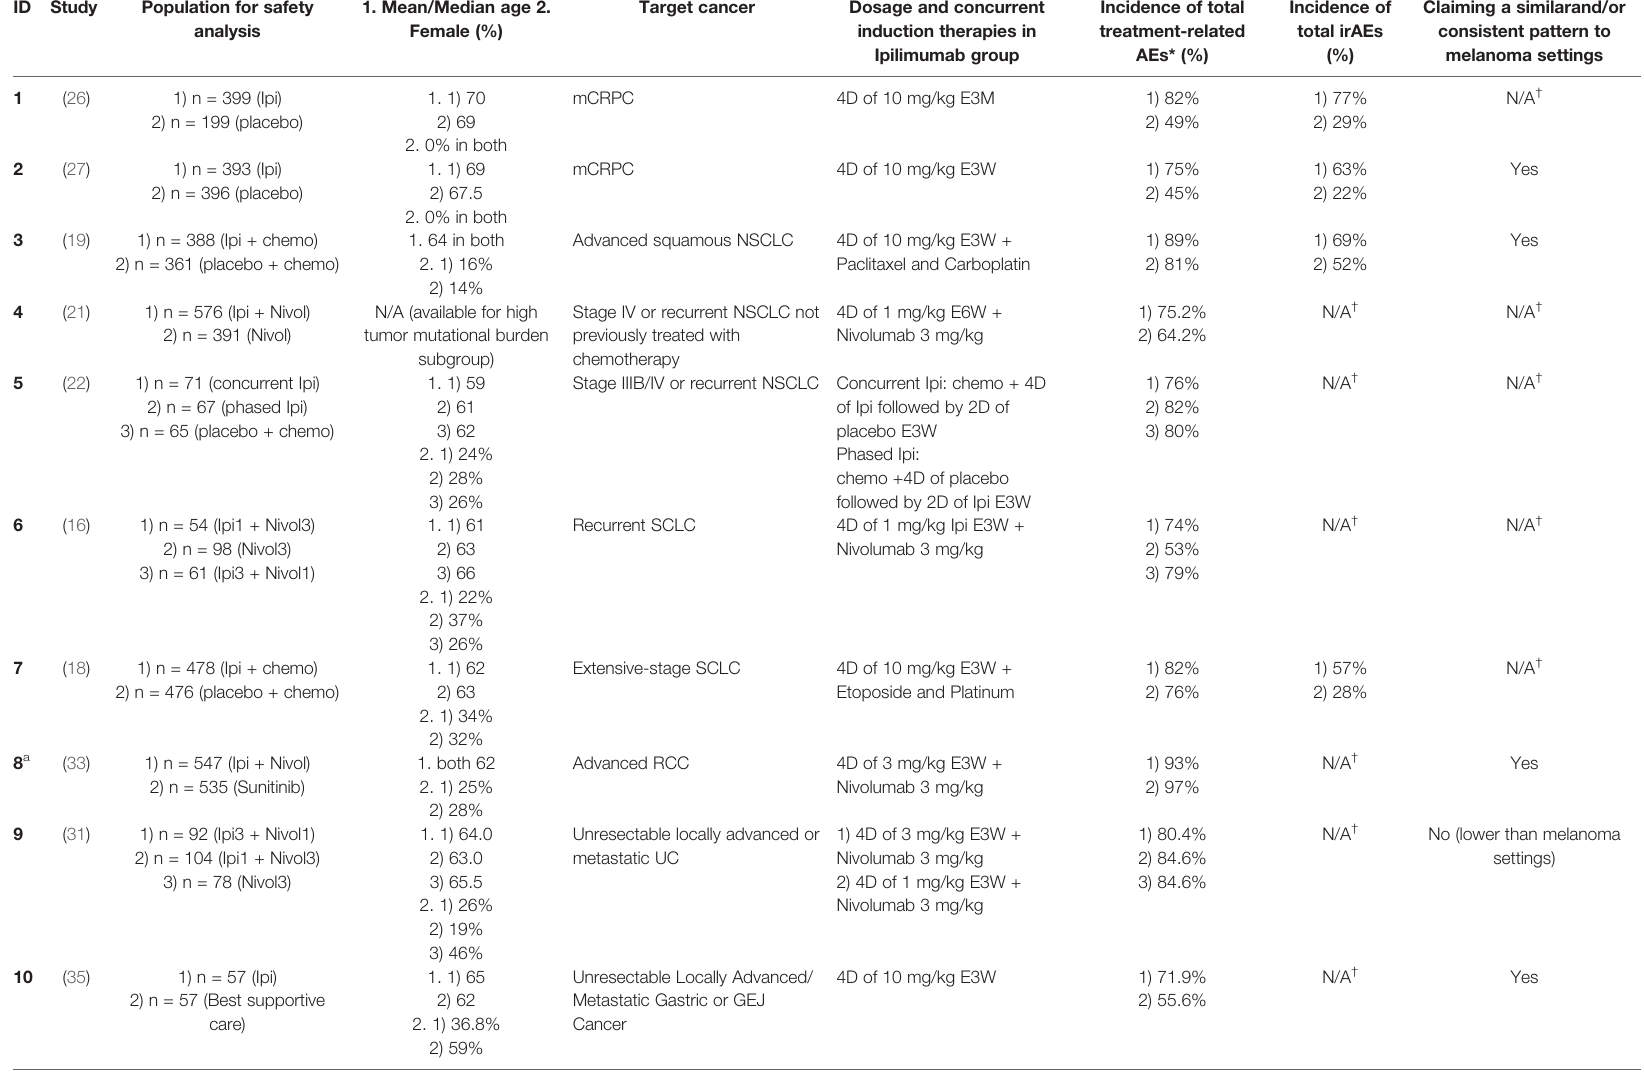
TABLE 2 | Summary of adverse events in non-melanoma cancers in clinical trials possessing ipilimumab group(s) of more than 50 patients and reporting safety pro fi